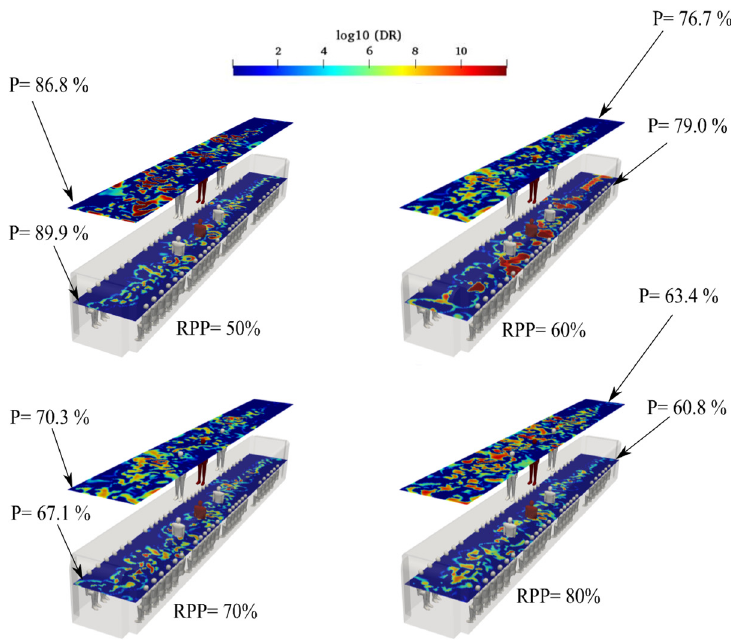
Figure 19. Evolution of the counters of log 10 (DR) when the infected individual was standing near the supply air ducts of the conventional HVAC systems (Case 3) with imperfect filtration at the time of 180 s for various removed particle present (RPP).